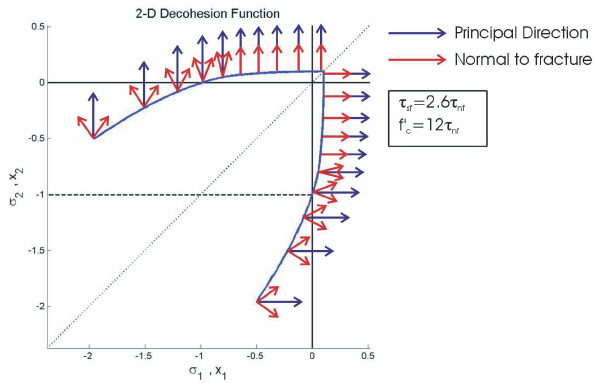
Fig. A1. Failure envelope in principal stress space for the elastic-decohesive